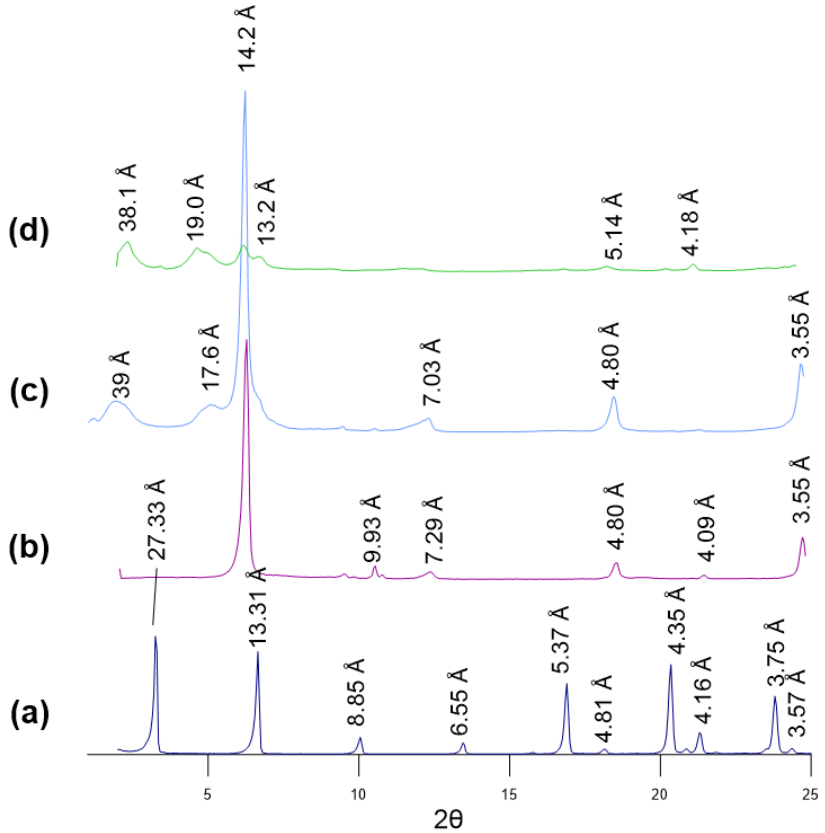
Figure 1. X-ray diffraction patterns of: ( a ) HDTMA, ( b ) raw, expanded vermiculite (VER), ( c ) 0.5 Figure 1. X-ray di ff raction patterns of: ( a ) HDTMA, ( b ) raw, expanded vermiculite (VER), HDTMA, and ( d ) 2.0 HDTMA. ( c ) 0.5 HDTMA, and ( d ) 2.0